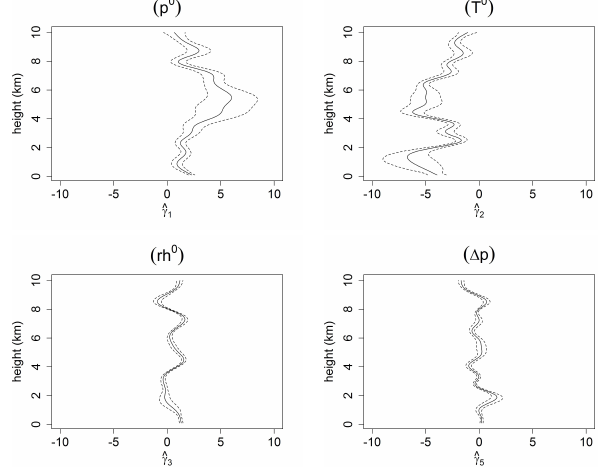
Figure 6a. Gamma functions of collocation error ω 2 for relative Figure 5. Beta functions for the Beltsville relative humidity (rh) col- Fig. 6. Gamma functions of collocation error ω 2 for relative humidity in Beltsville using model (15) . Top left: Sterling pressure (cid:0) p 0 (cid:1) ; top Fig. 5. Beta functions for Beltsville relative humidity ( rh ) collocation drift model (14) . Top left: Sterling relative humidity (cid:0) rh 0 (cid:1) ; top right: humidity in Beltsville using model ( 15). Top left: Sterling pressure location drift model ( 14). Top left: Sterling relative humidity (rh 0 ); right: Sterling temperature (cid:0) T 0 (cid:1) ; bottom left: Sterling relative humidity (cid:0) rh 0 (cid:1) ; bottom right: difference in pressure (∆ p ) . Figure 1 of 2. Sterling mixing ratio (cid:0) mr 0 (cid:1) ; bottom left: difference in mixing ratio (∆ mr ) . (p 0 ) ; top right: Sterling temperature (T 0 ) ; bottom left: Sterling rel- top right: Sterling mixing ratio (mr 0 ); bottom left: difference in mix- A. Fass`o et al.: Collocation uncertainty in atmospheric profiles ative humidity ( rh 0 ) ; bottom right: difference in pressure (1p) . ing ratio (1 mr ) .